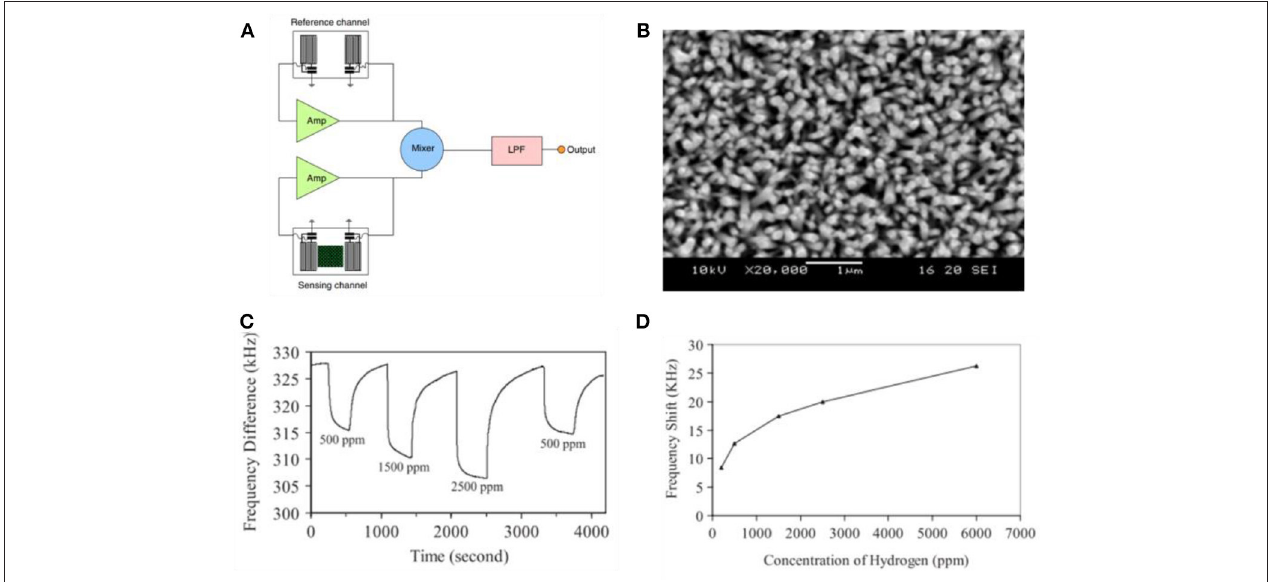
FIGURE 9 | (A) , Schematic diagram of a sensor fabrication. (B) , SEM images of as prepared Pt/ZnO nanorod arrays. (C) , The dynamic responses of the dual-channel sensor for different H 2 concentrations. (D) , Changes in frequency with H 2 concentration. Reprinted with permission from Huang et al. (2009), copyright 2009 IOP Publishing Ltd.